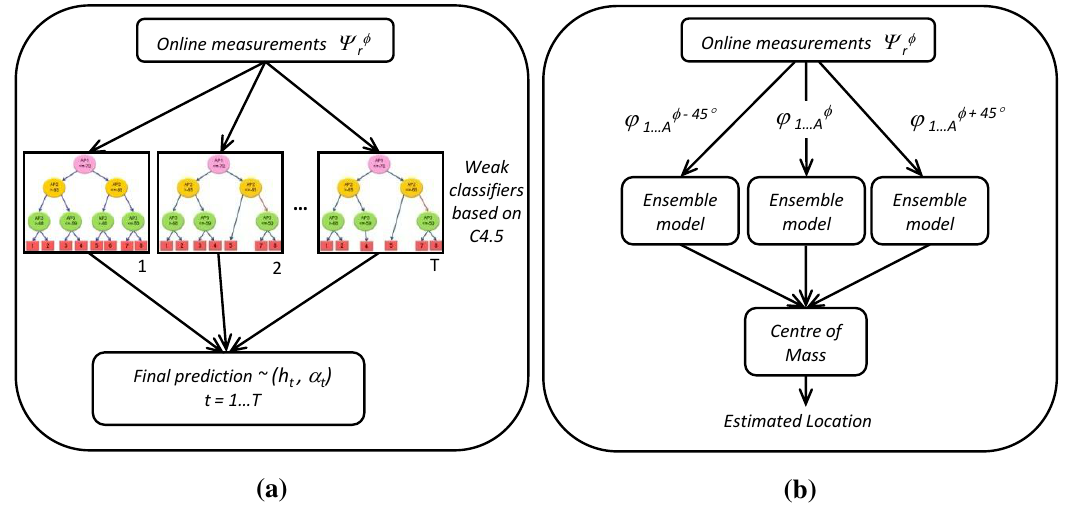
Figure 1. ( a ) Multiple weighted decision trees (ensemble model); ( b ) proposed system in the test